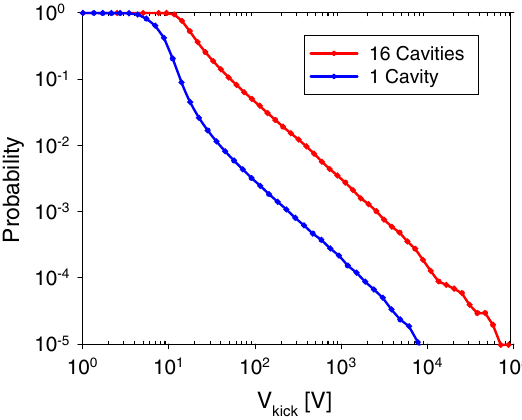
FIG. 15. Cumulative probability of HOM transverse kick in the single 3.9 GHz cavity (blue line) and in the third-harmonic section (red line) of the LCLS-II